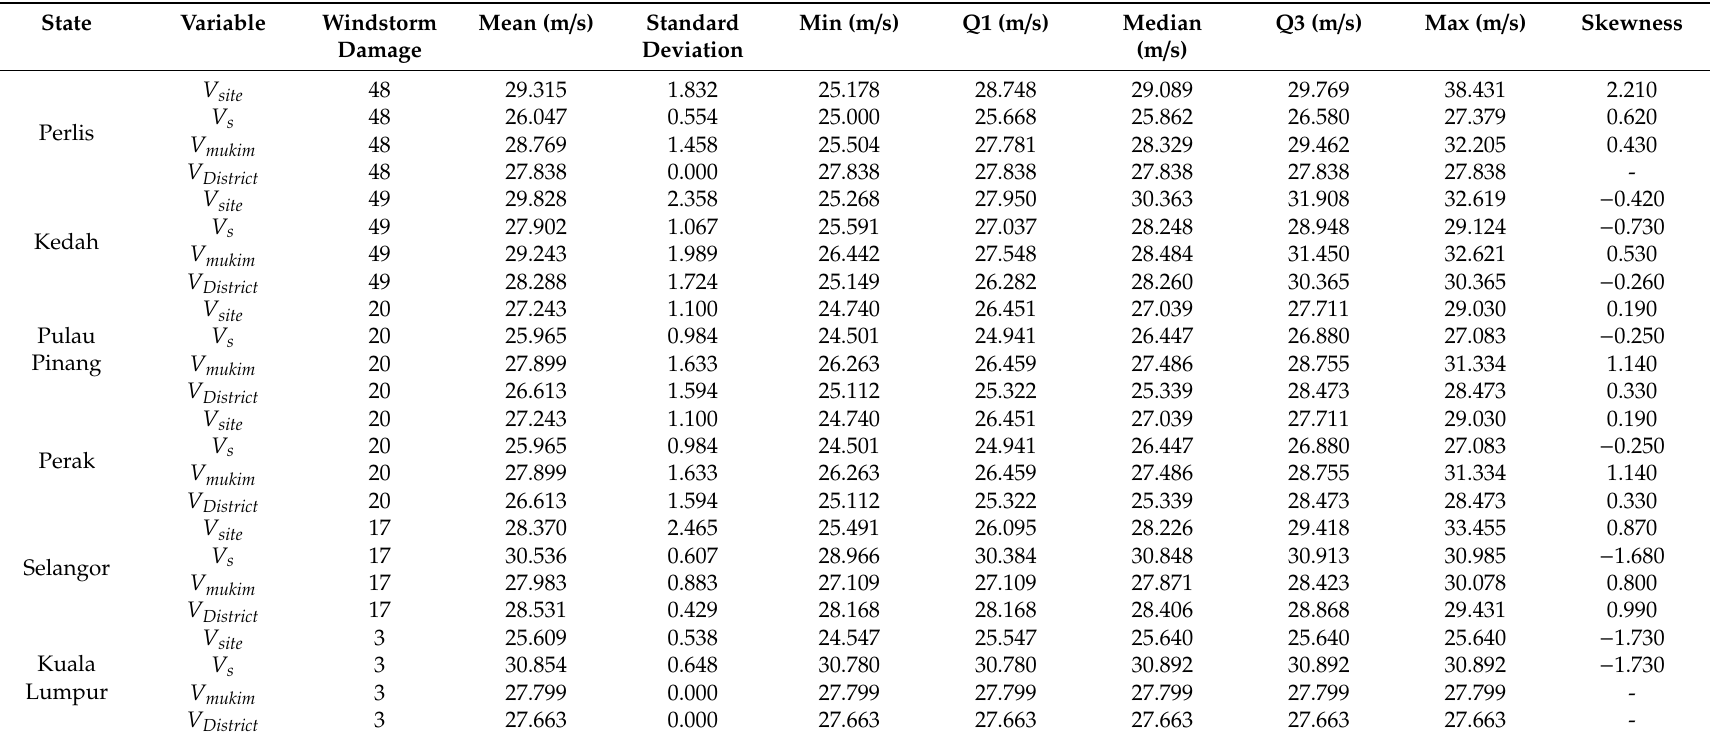
Table A1. Summary of the statistical analysis of windstorm damage cases for each State in Peninsular